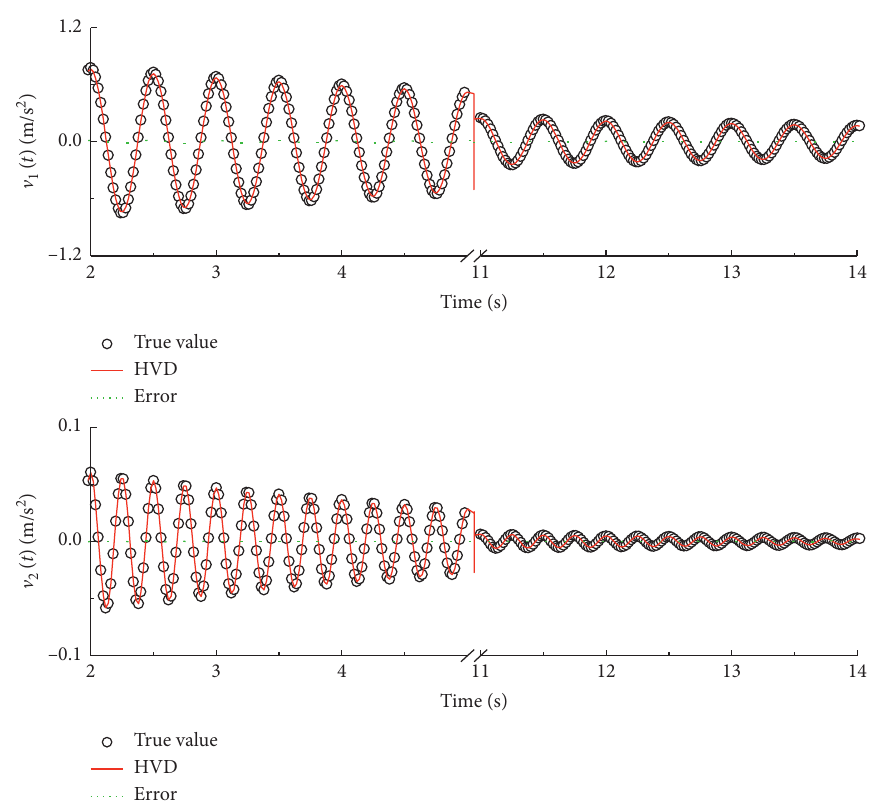
Figure 6: Modal responses of a 2 DOF system (HVD